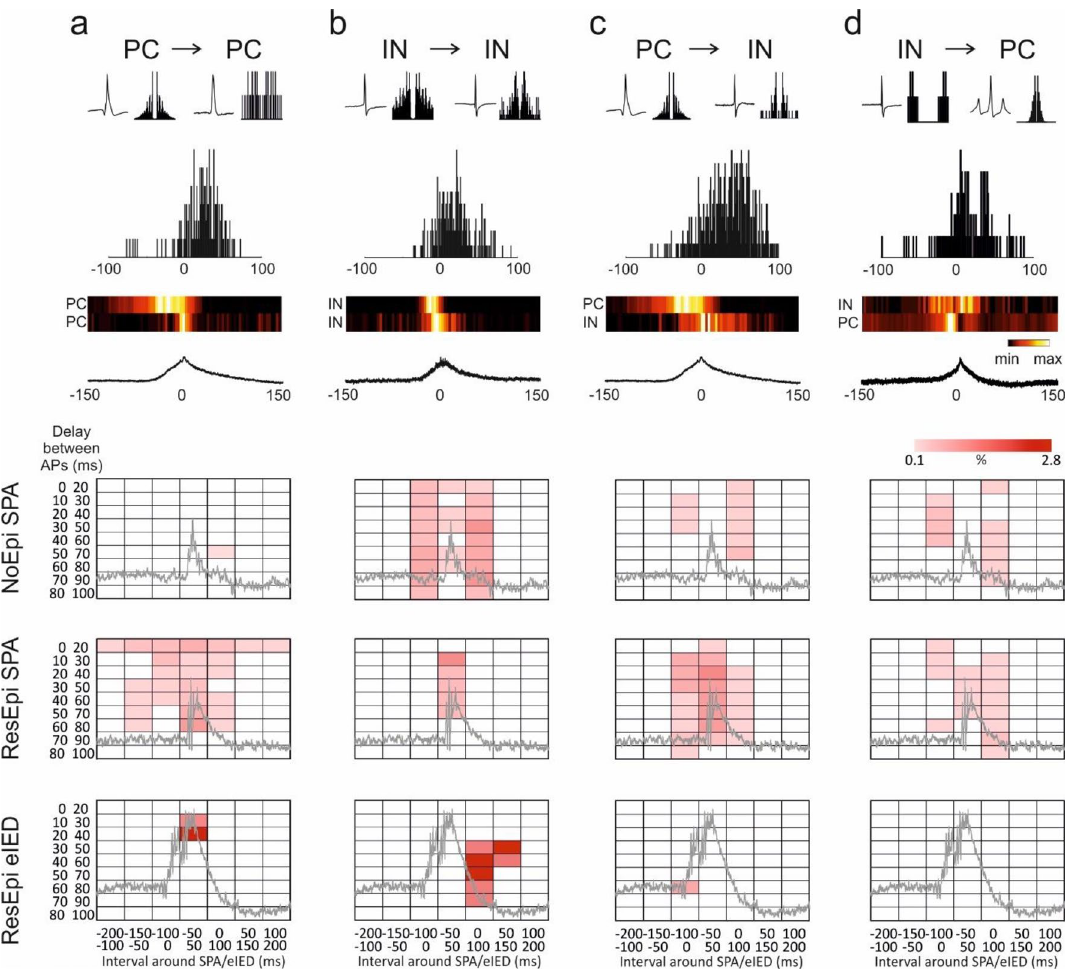
Figure 5. Cellular interactions during SPA and eIED. We examined how neuronal firing affects discharge in other cells. Examples for PC to PC ( a ), IN to IN ( b ), IN to PC ( c ) and PC to IN ( d ) firing sequences. ( a–d ) AP waveform and the auto-correlogram of the two respective cells are shown in the first row, the asymmetric cross-correlogram in the second row. The heat maps show the firing of the cells relative to the respective SPA (lower trace). Hot colours depict increased firing frequency (min: minimal, max: maximal firing rate). Note that the bursting PC in ( a ) is the same as the PC on ( c ) driving both a PC and an IN. The lower panels show the percentages of significant cellular interactions, checked at different, 100 ms long time intervals around the LFPg peak of the SPA/eIED events (between − 200 and + 200 ms, x-axes), as well as at different delays between the cells (20 ms long delay intervals, between 0 and 100 ms, y-axes). Only one PC-PC interaction was found during NoEpi SPA (first panel), while numerous PC-PC interactions characterised ResEpi SPA (second panel). The timing of all types of neuronal interactions was mostly symmetric around the LFPg peak of NoEpi SPA (first row panels) and ResEpi SPA (second row panels), while it was asymmetric around the peak of eIEDs (bottom row panels). Around ResEpi eIED (bottom row panels) PC-PC interactions were shorter in delay (up to 40 ms) and concentrated at the peak, while IN-IN interactions appeared after the peak of the eIEDs (0–150 ms) with a higher delay (up to 90 ms). During NoEpi SPA (first row panels) PC-IN and IN-PC interactions appeared equally around the peak. During ResEpi SPA, higher numbers of PC-IN than IN-PC interactions were observed. Light pink to dark red rectangles depict increased percentages of significant cell–cell interactions. For exact numbers see Suppl. Table